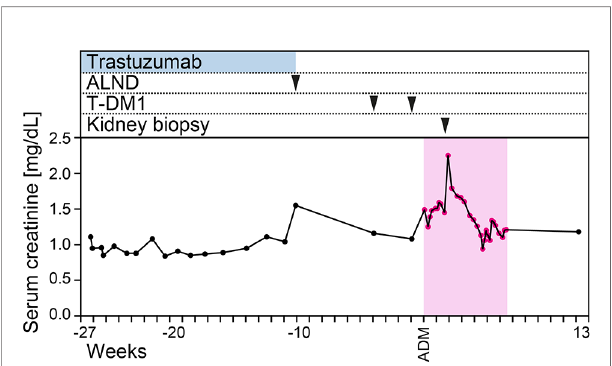
FIGURE 1 | Time course of the case. Time course of serum creatinine levels, trastuzumab and T-DM1 infusions, and kidney biopsy. Abbreviations: ADM, admission; ALND, axillary lymph node dissection; T-DM1, ado- trastuzumab